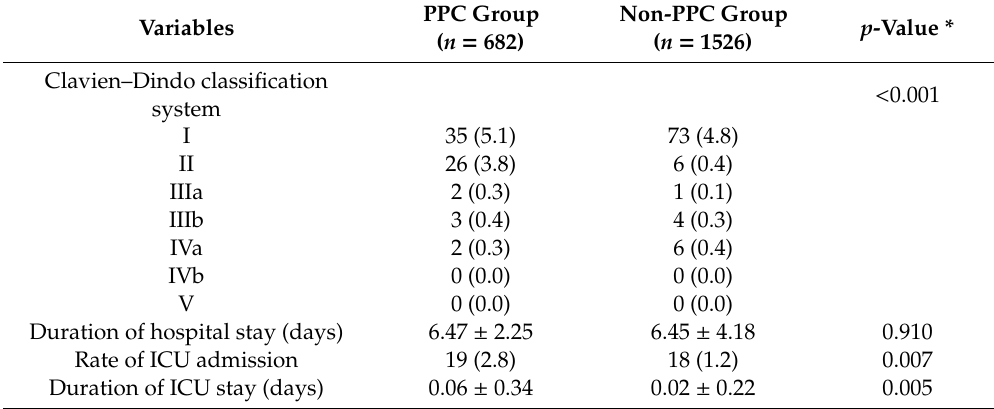
Table 4. Postoperative